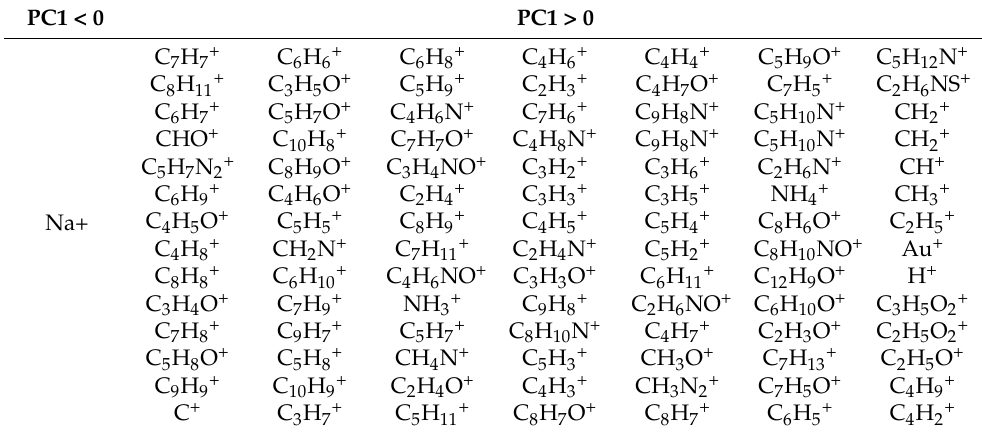
Table 2. PC1 loadings list related to the functionalized AuNP/VEGF Gly FAM. PC1 <